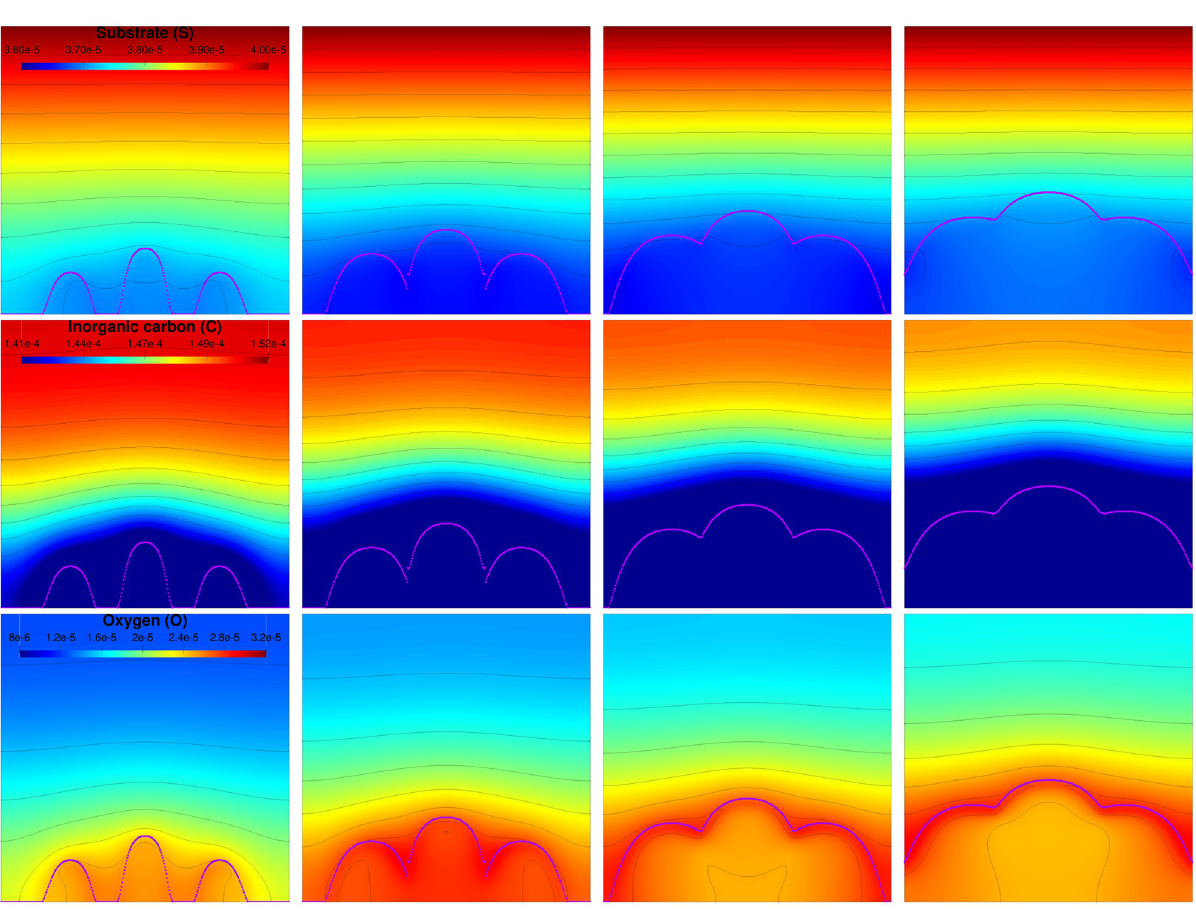
Fig 8. Concentration of the dissolved components at times t = 5, t = 10, t = 15 and t = 20 days for a biofilm starting from a three spot colony. First line: substrate distribution ( S ). Second line: inorganic carbon distribution ( C ). Third line: oxygen distribution ( O ). The purple dotted line represents the biofilm outer contour defined as the largest value for the biofilm gradient.